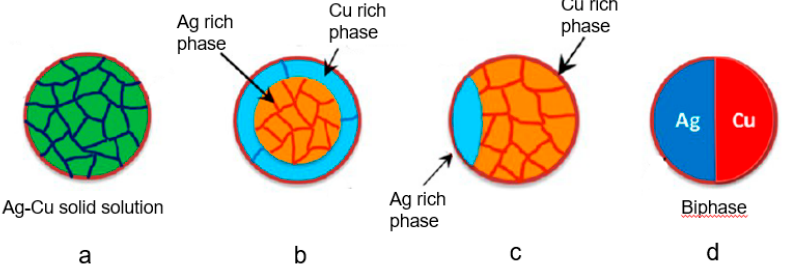
Figure 11. ( a ) Single-phase AgCu solid solution; ( b ) core-shell structure of AgCu nanoalloys; ( c ) structure of Ag and Cu in both phases; ( d ) biphasic. Reproduced with permission from Reference [254]. Copyright 2016, American Chemical Society.